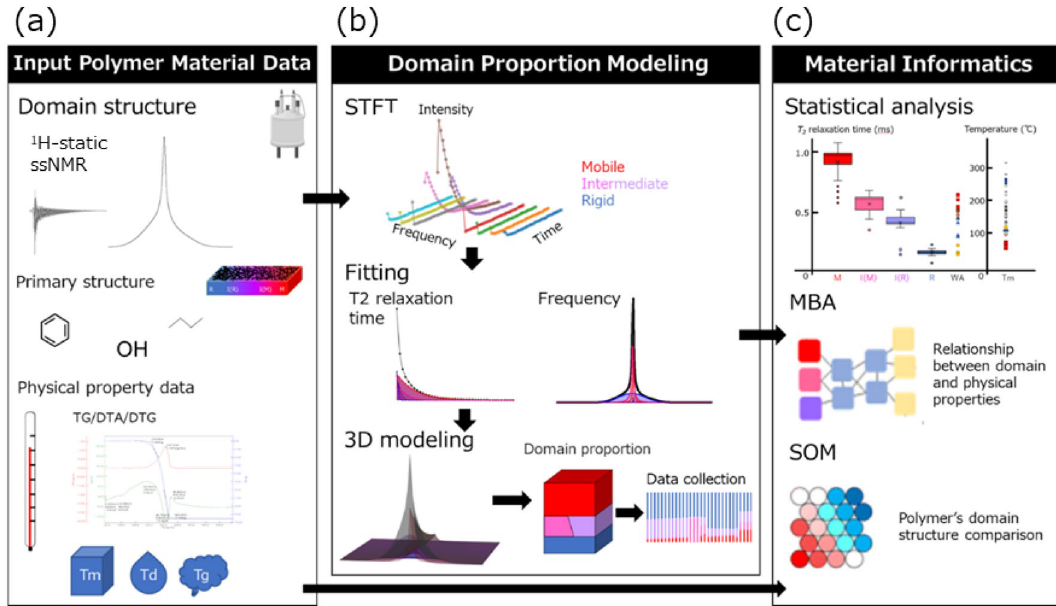
Figure 1. Conceptual diagram of materials informatics approach to exploring structure–property relationships using domain modeling. ( a ) To exploring relationships between structure and property of polymer materials, 1 H-static solid-state NMR (ssNMR) spectrum, primary structure information and physical property data obtained from TG, DTA and DTG were used. ( b ) Domain modeling was applied to the input 1 H-static ssNMR spectrum of polymer materials to obtain domain structural information. ( c ) The domain proportion, primary structure data and thermophysical property data were integrated for data analysis such as statistical analysis, SOM and MBA. 1 H-static ssNMR, Proton static solid-state nuclear magnetic resonance; TG, Thermogravimetry; DTA, Differential thermal analysis; DTG, Derivative thermogravimetry; T m , Melting temperature; T d , Thermal decomposition temperature; T g , Glass transition temperature; STFT, Short-time Fourier transform; MBA, Market basket analysis; SOM, Self-organization